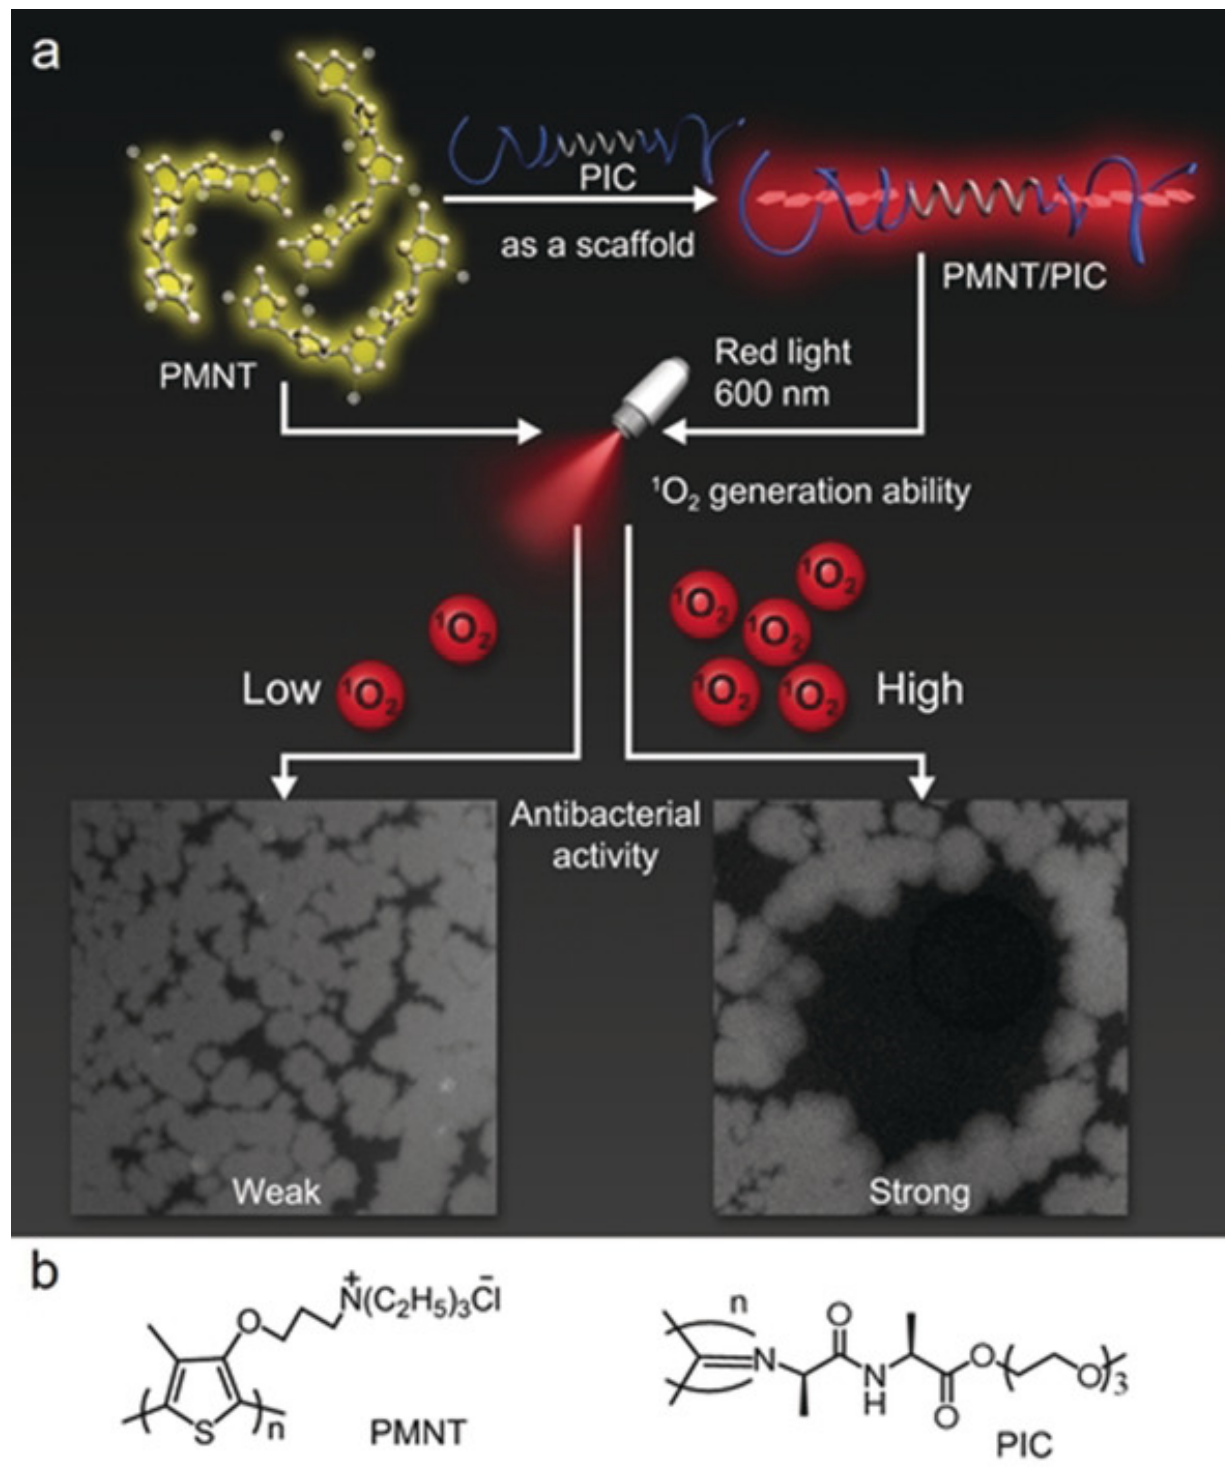
Figure 8. ( a ) Schematic of the assembly of PMNT/PIC, and its antibacterial activity under red light. ( b ) Chemical structure of PMNT and PIC. Reprinted with permission from Ref. [90]. Copyright 2021 Wiley-VCH.